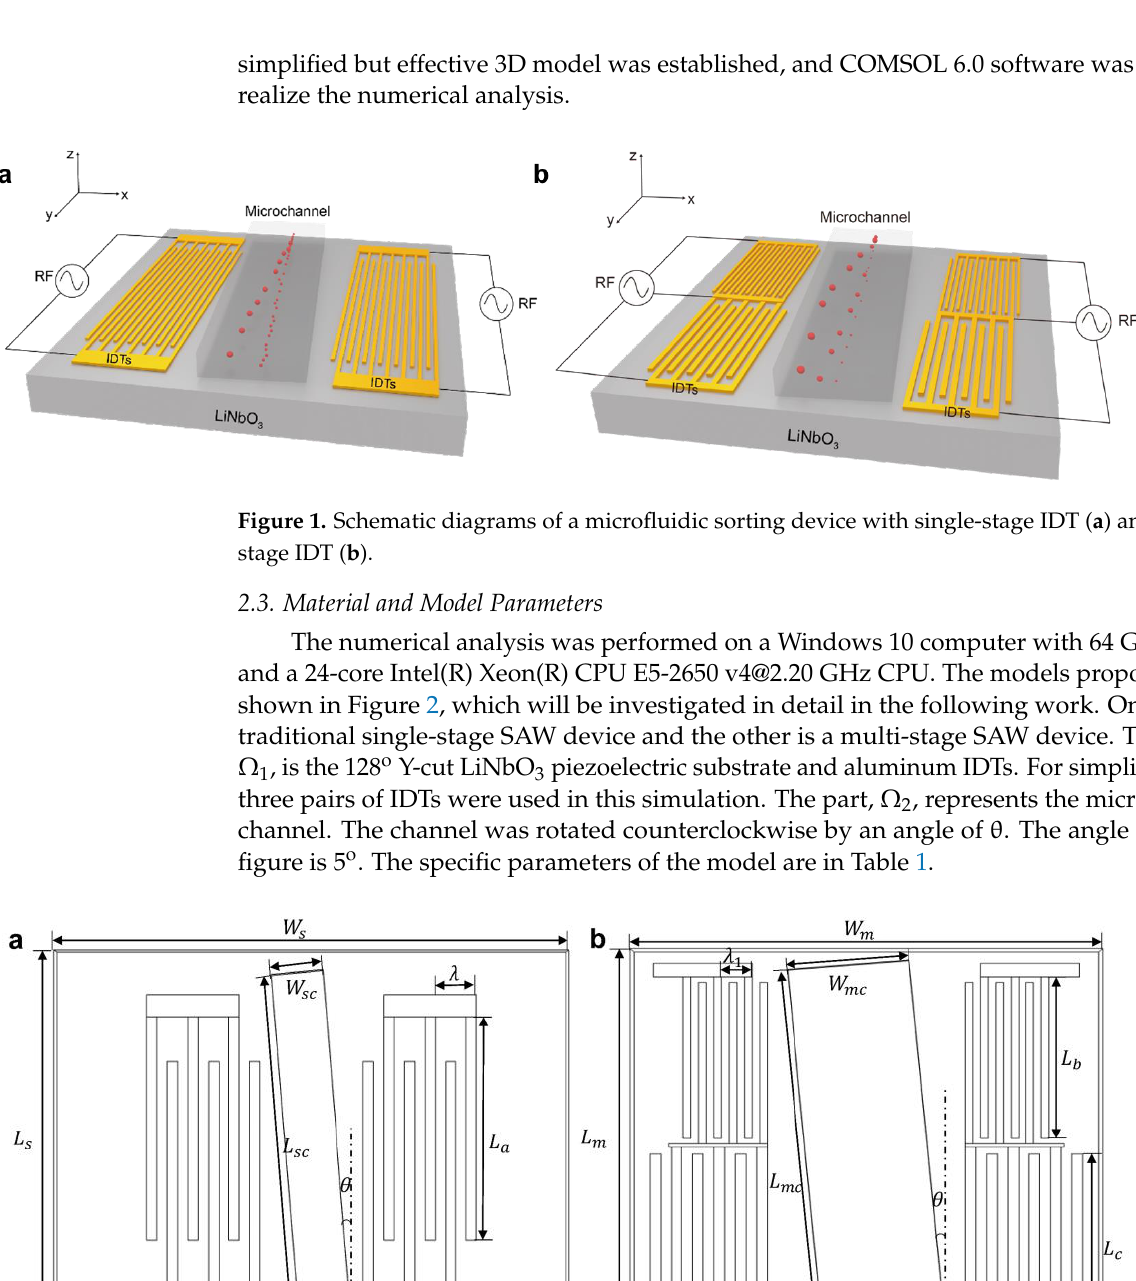
Figure 2. Diagram of the microfluidic particle sorting device with a pair of IDTs ( a ) and multiple pairs of IDTs ( b ).